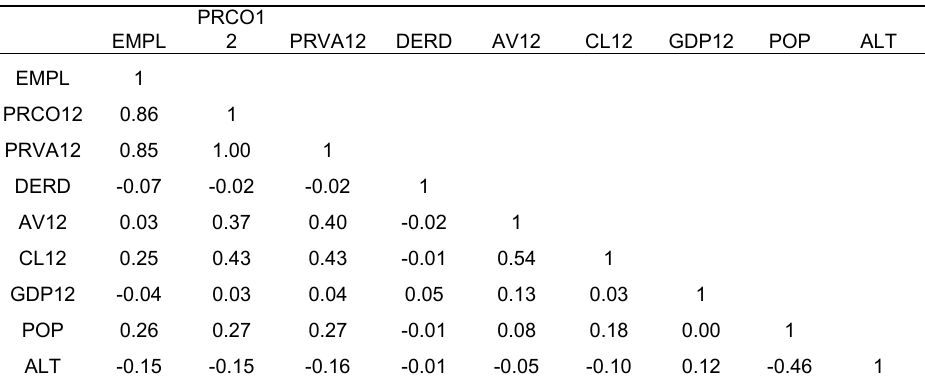
Table 5: Correlation of dependent